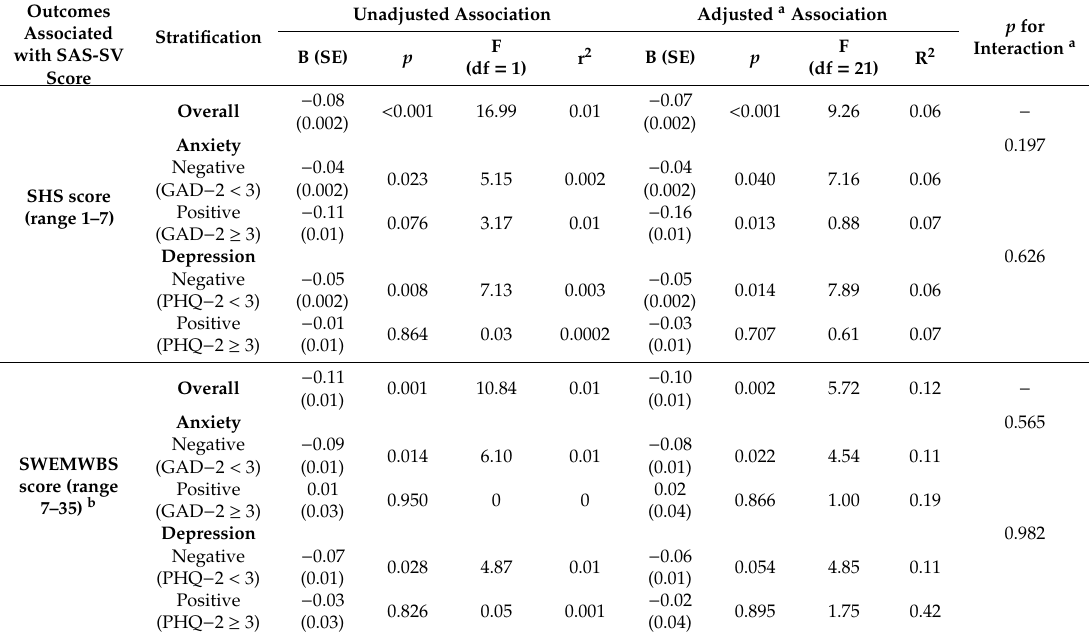
Table 3. Standardized beta (B) of SHS and SWEMWBS scores associated with SAS-SV score ( N = 4054). Outcomes Associated with SAS-SV